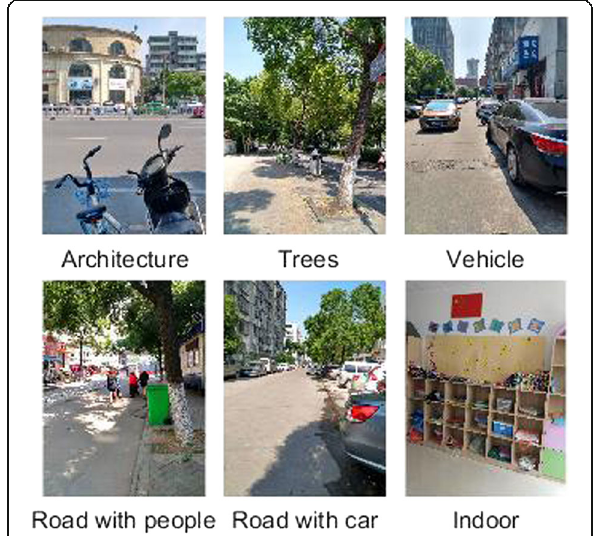
Fig. 2 The scene pictures taken in this paper